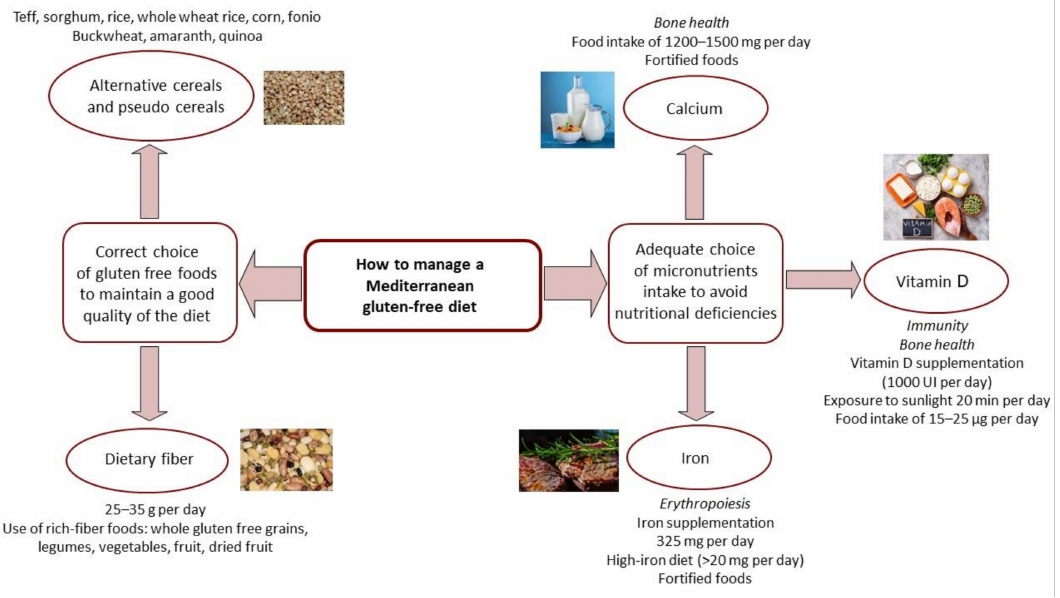
Figure 1. Recommendations for maintaining a healthy Mediterranean gluten-free